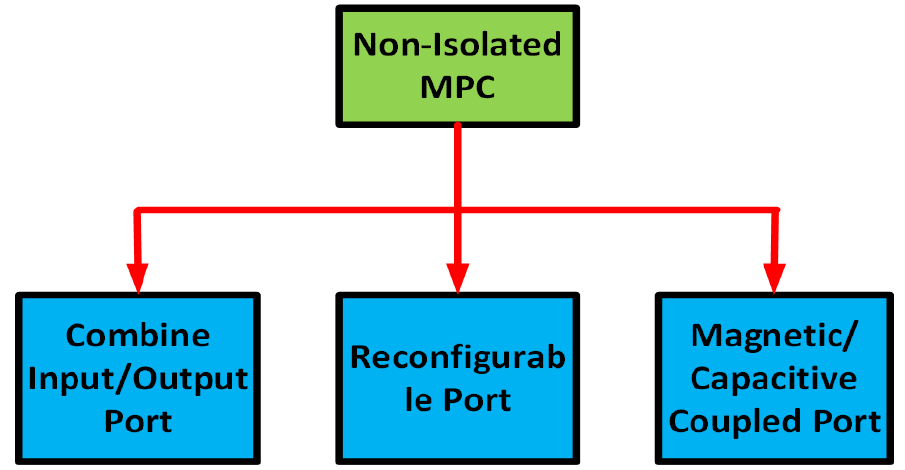
Figure 25. General classification of a non-isolated MPC.